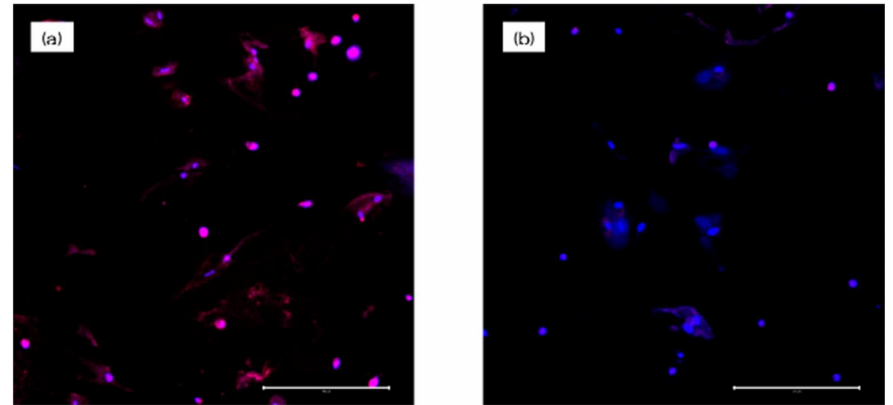
Figure 9. Macrophages on the NANOZR plate displayed a significantly higher level of intracellular ROS than those on the UV-NANOZR plate, along with the highest concentration of DNA. ( a ) untreated NANOZR; ( b ) UV-NANOZR. (scale bar: 200 µ